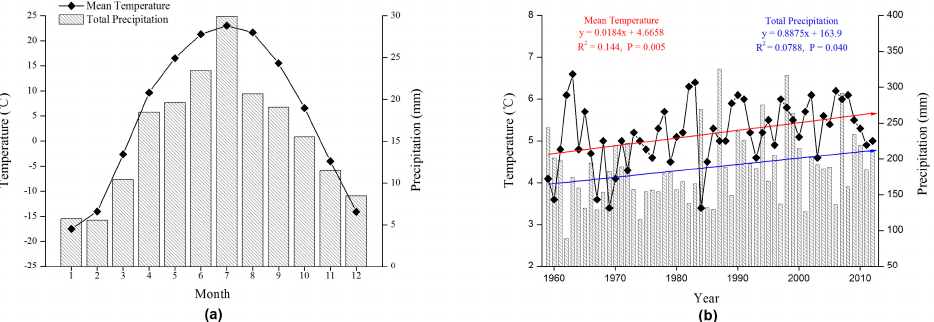
Figure 2. Mean temperature and total precipitation during 1960–2012 using the records from the Qitai meteorological station, northwest China. ( a ) Monthly total precipitation and mean temperature averaged; ( b ) Variation trends of annual total precipitation and mean temperature; the lines with arrows represent the simulated trends by linear regression.